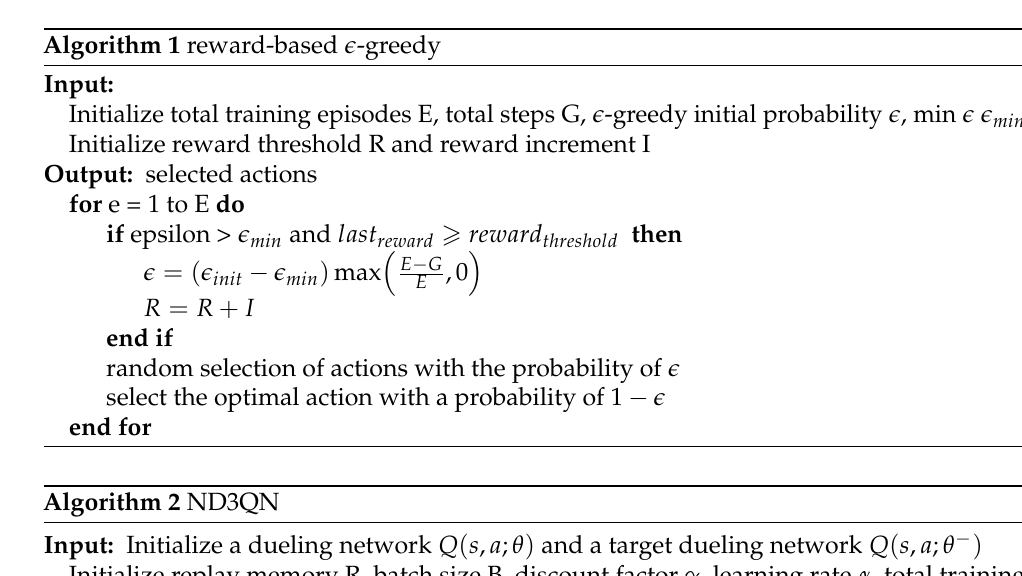
Algorithm 1 reward-based (cid:101) -greedy